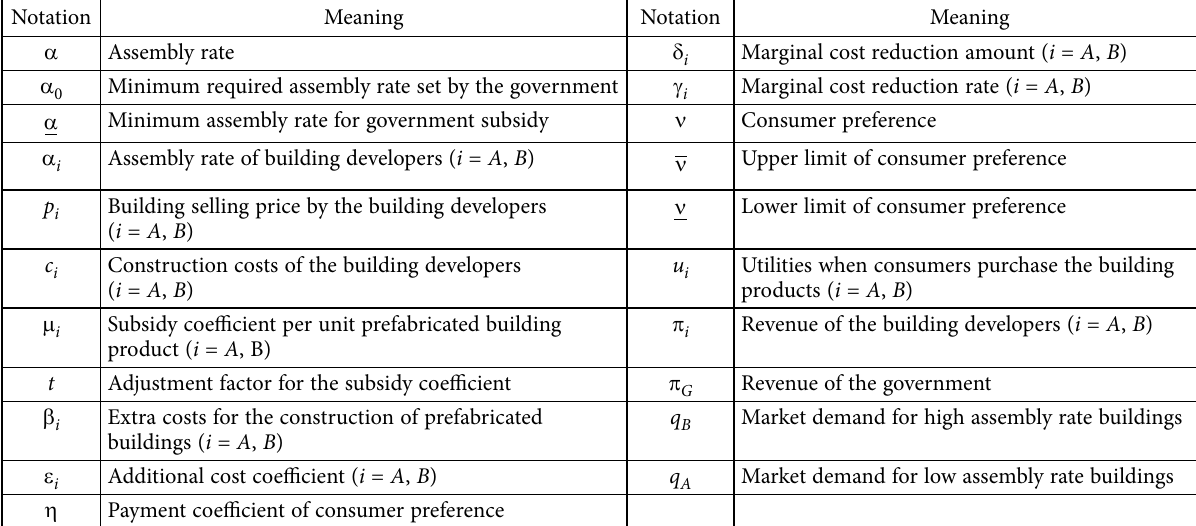
Table 1. Summary of